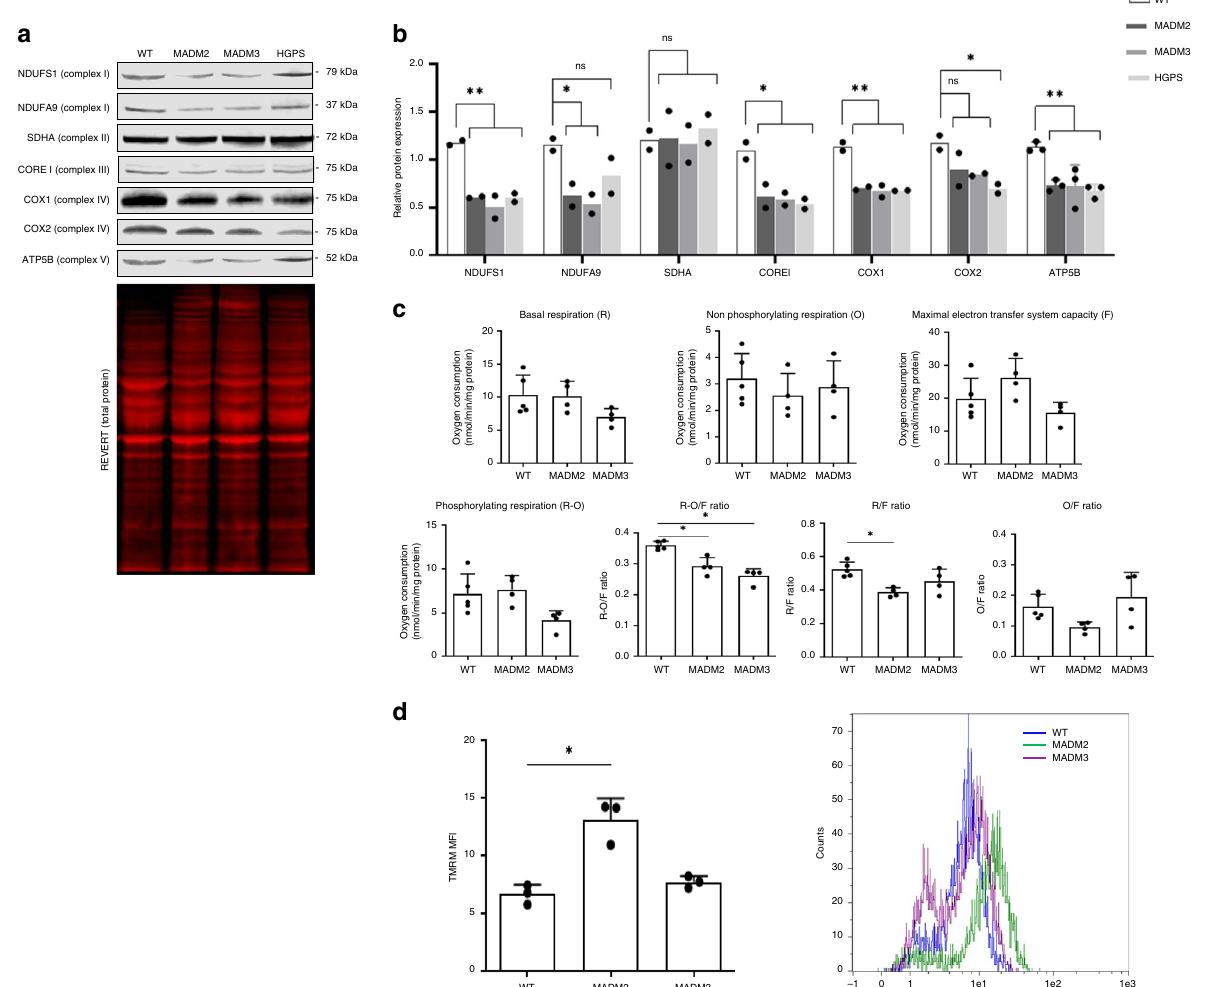
Fig. 3 Respiratory chain composition and function is impaired in MADaM fi broblasts. a Representative western blots of respiratory chain proteins of complex I (NDUFS1, NDUFA9), complex II (SDHA), complex III (CORE I), complex IV (COX1, COX2), and complex V (ATP5B) in whole lysates from healthy control (WT), MADM2, MADM3, and HGPS fi broblasts. Protein levels were quanti fi ed by ImageJ software and their expression levels were normalized to REVERT total protein. b Quantitative analysis of western blots of respiratory chain proteins from complex I (NDUFS1, NDUFA9), complex II (SDHA), complex III (CORE I), complex IV (COX1, COX2), and complex V (ATP5B) from a healthy control (WT), MADM2, MADM3, and HGPS fi broblasts. Protein expression levels were normalized to Revert total protein using ImageJ software. Results are expressed as the mean, for ATP5B the mean ± SD is shown; n = 3 independent experiments for ATP5B and n = 2 independent experiments for all other proteins. One-way anova was performed comparing patients ’ values to control (exact p values: NDUFS1: p MADM2 = 0.0034, p MADM3 = 0.002, p HGPS = 0.008; NDUFA9: p MADM2 = 0.041, p MADM3 = 0.025, p = 0.140; SDHA: p = 0.954, p = 0.89, p = 0.689; COREI: p = 0.0188, p = 0.0154, p = 0.011; COX1: HGPS MADM2 MADM3 HGPS MADM2 MADM3 HGPS p MADM2 = 0.0014, p MADM3 = 0.0011, p HGPS = 0.0012; COX2: p MADM2 = 0.1129, p MADM3 = 0.074, p HGPS = 0.0257; ATP5B: p MADM2 = 0.0035, p MADM3 = 0.0034, p HGPS = 0.0016) ( p values: * p < 0,05, ** p < 0.01, ns not signi fi cant. c Basal (R), oligomycin (O), and FCCP (F) respirations were studied in healthy (WT) and MADM2 and MADM3 fi broblast cell lines at passage P8. Respiratory ratios, including RCR (O/F) and RCRp (R-O/F) are also expressed for the respiration measured at 48 h. Data are expressed as mean ± SD of n = 4 independent experiments; statistical signi fi cance was analyzed using two-tailed Mann – Whitney test, 95% CI; * p = 0.015 in all cases. d The graph (left panel) shows quanti fi cation of tetramethylrhodamine methyl ester (TMRM, 50 nM) mean fl uorescence intensity (MFI) signal measured by FACS analysis (right panel) in control (WT) and MADM2 and MADM3 fi broblasts. The counts shown in the right panel indicate the number of mitochondria quanti fi ed in this study, obtained from n = 3 independent experiments. Data are expressed as mean ± SD; statistical signi fi cance was analyzed using two-tailed unpaired Student ’ s t test, 95% CI; * p MADM2 = 0.015. FACS sequential gating/sorting strategies are provided in Supplementary Fig. 12 and source data are provided as a Source Data fi